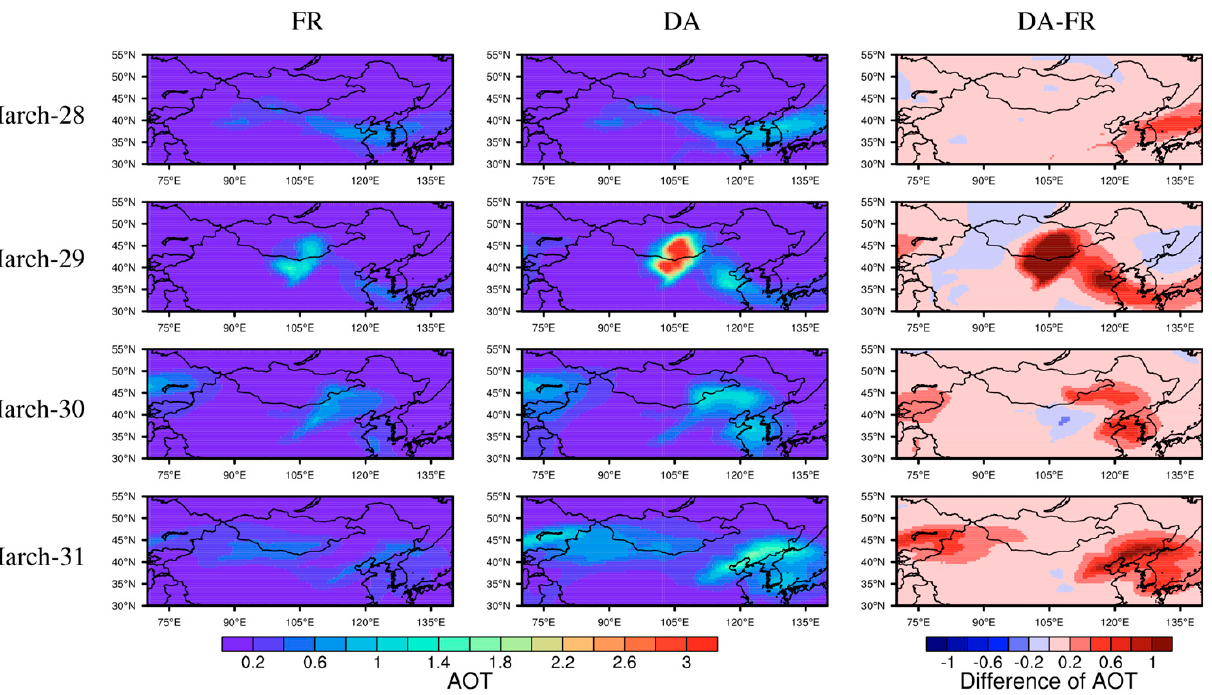
Figure 4. Spatial distributions of the daily mean dust AOTs from 28 to 31 March 2018 for FR and DA experiments with differences in daily mean dust AOTs between the two experiments.